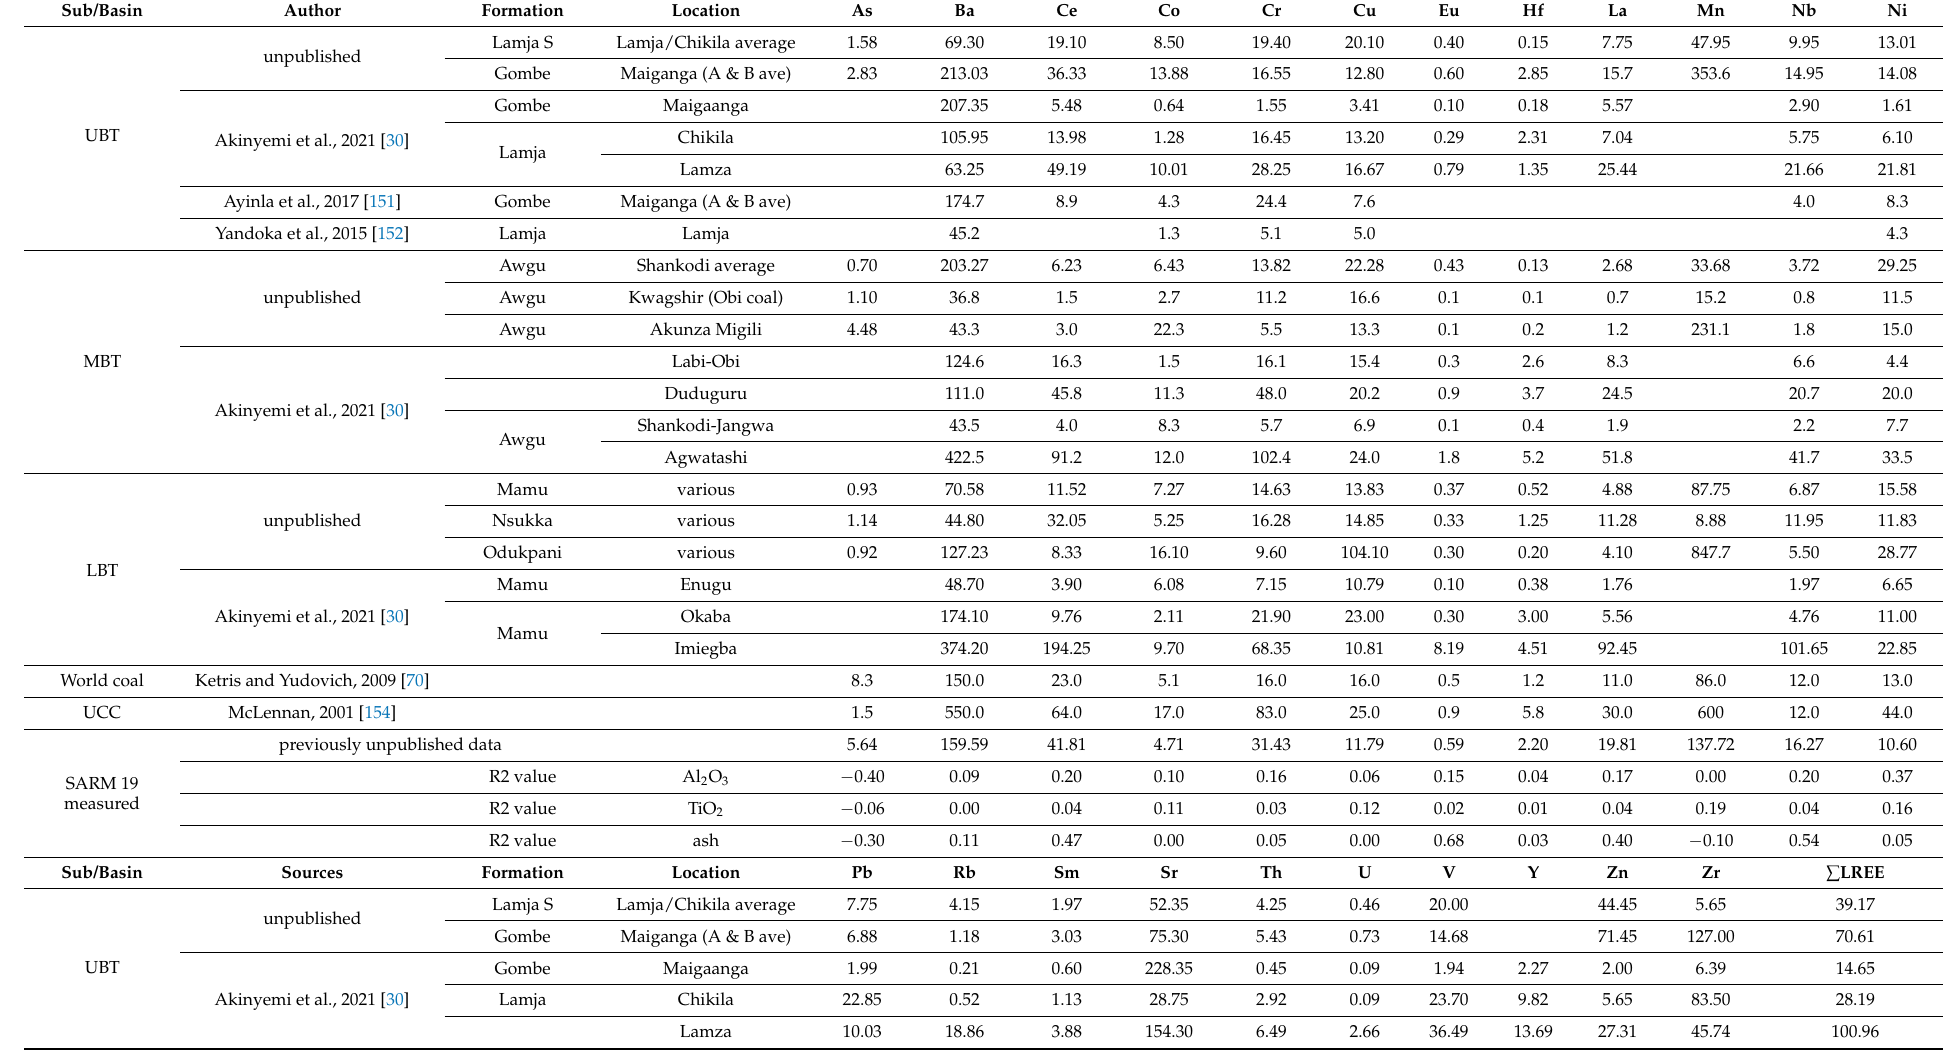
Table 8. Geochemical data: Select trace and rare earth elements for Nigeria Cretaceous coals (whole-coal basis; ppm).